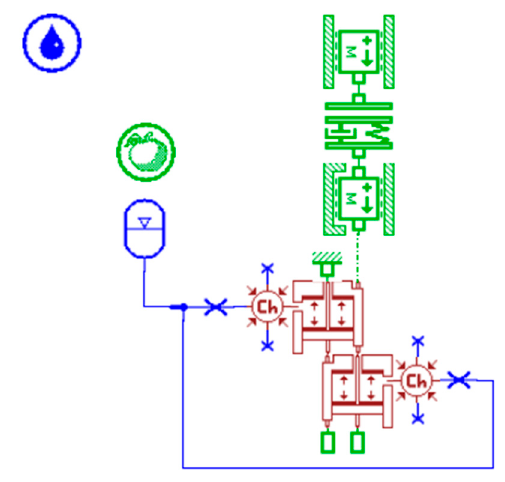
Figure 4. Dynamic model of hanging basket drop.